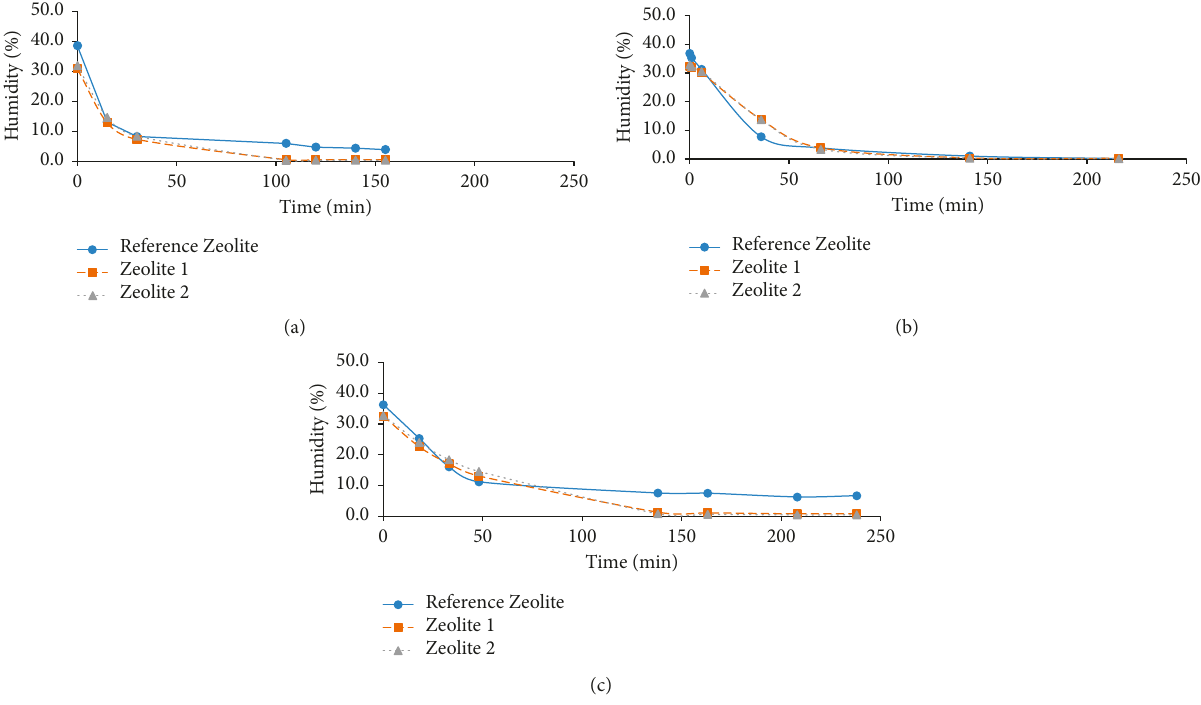
Figure 2: Evolution of the capacity of zeolites to release water at different temperatures: (a) 145 ° C; (b) 130 ° C; (c)120 °